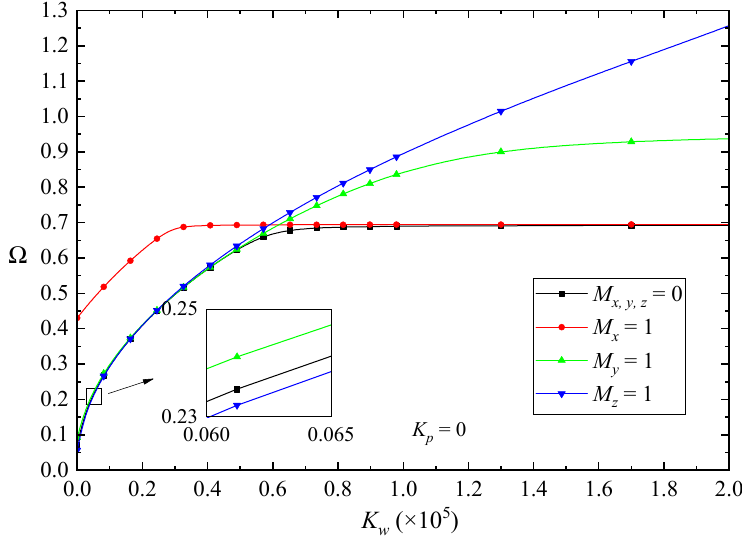
Ω of the beams in